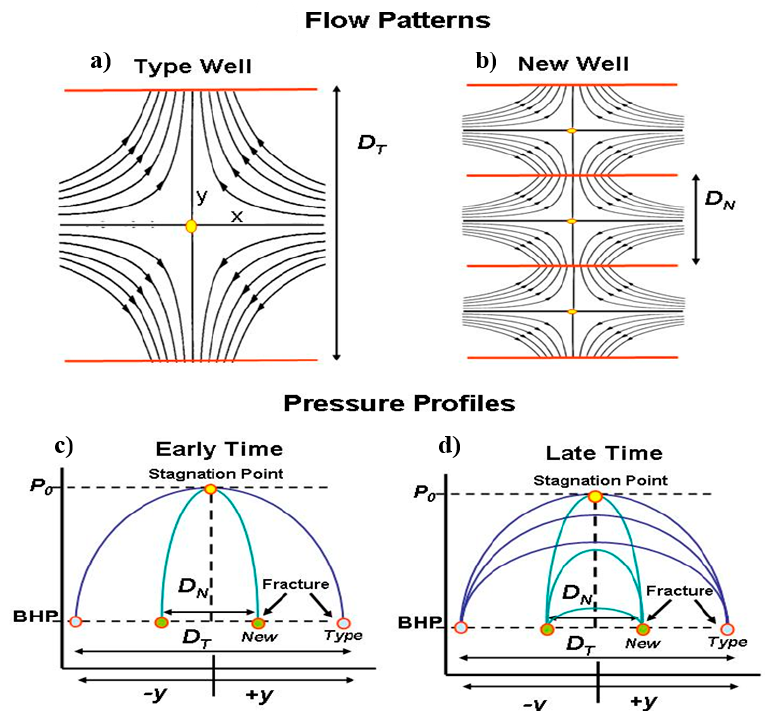
Figure 4. Principle sketch of flow-cell model key aspects. ( a ) Map view of streamlines for type well and a new well with narrower fracture spacing. ( b ) Comparison of pressure depletion profiles along line x = 0 for both type well and new well: ( c ) Early times, and ( d ) late times (adapted from Reference [10]). The sensitivity of well performance to fracture spacing and well spacing distance for a relatively high permeability assumption (850 nD base case) are given in Sections 2.2 and 2.3,